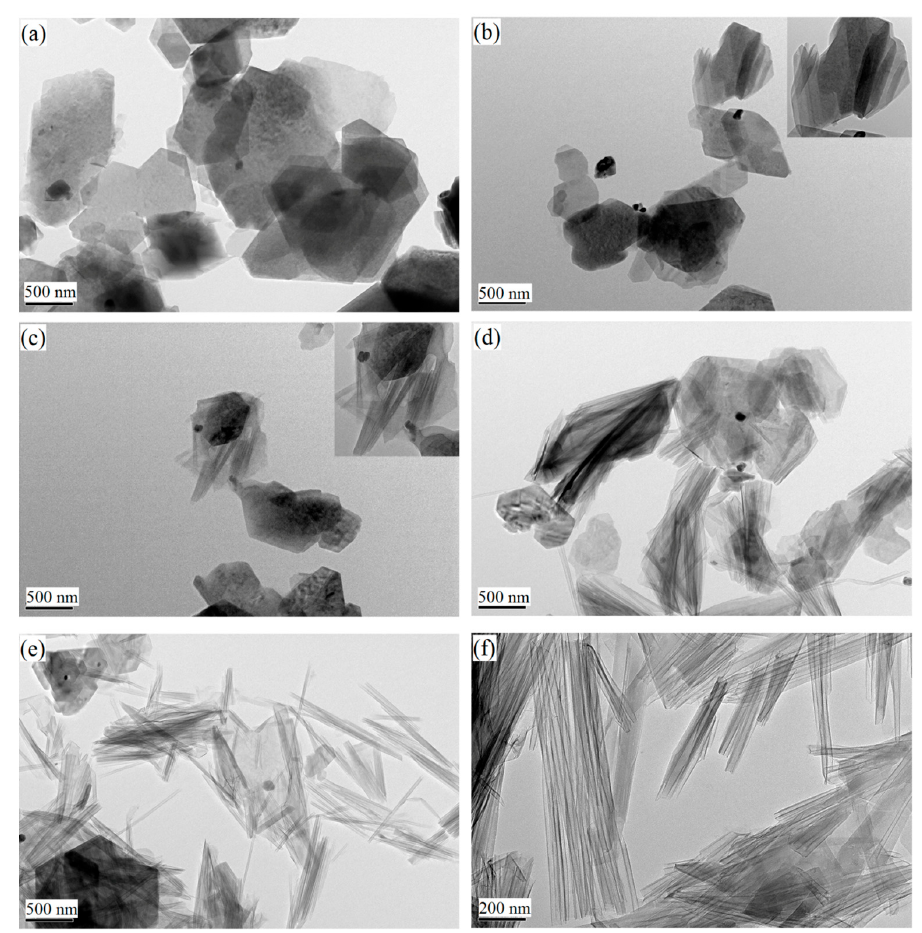
Figure 3. TEM images of ( a ) K, ( b ) K-Qa-C 4 , ( c ) K-Qa-C 6 , ( d ) K-Qa-C 8 , ( e ) K-Qa-C 14 , and ( f ) K-Qa-C 18 .